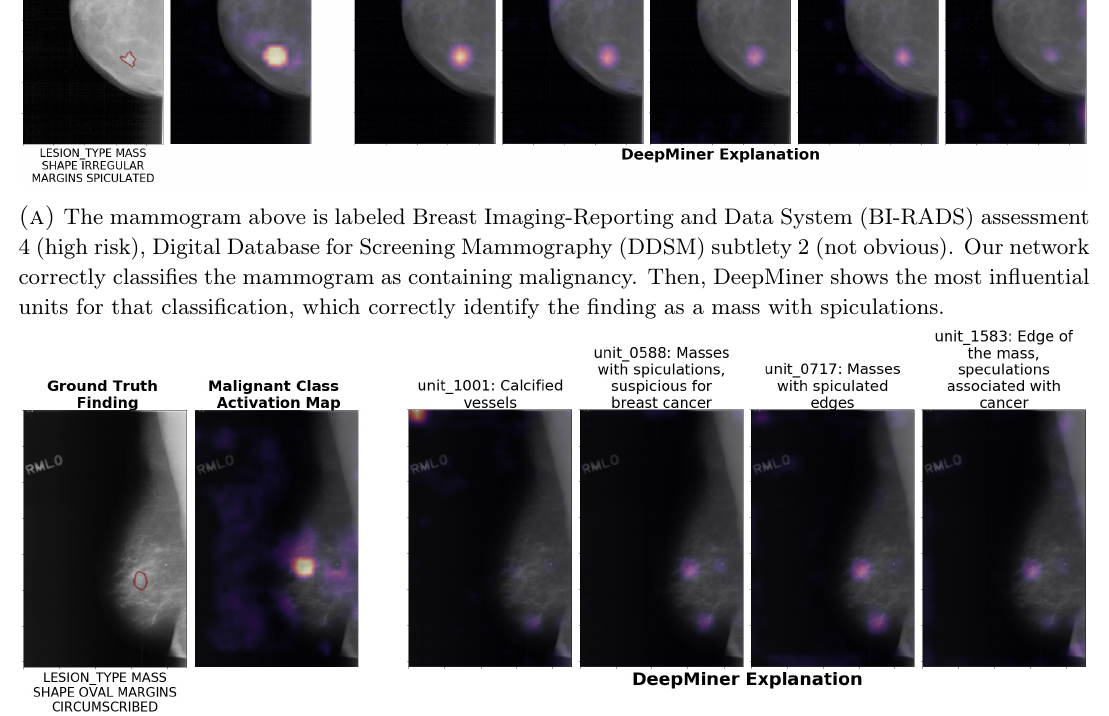
Figure 4. Malignant DeepMiner explanations: Sample DeepMiner explanations of mammograms classified as malignant. Best viewed in